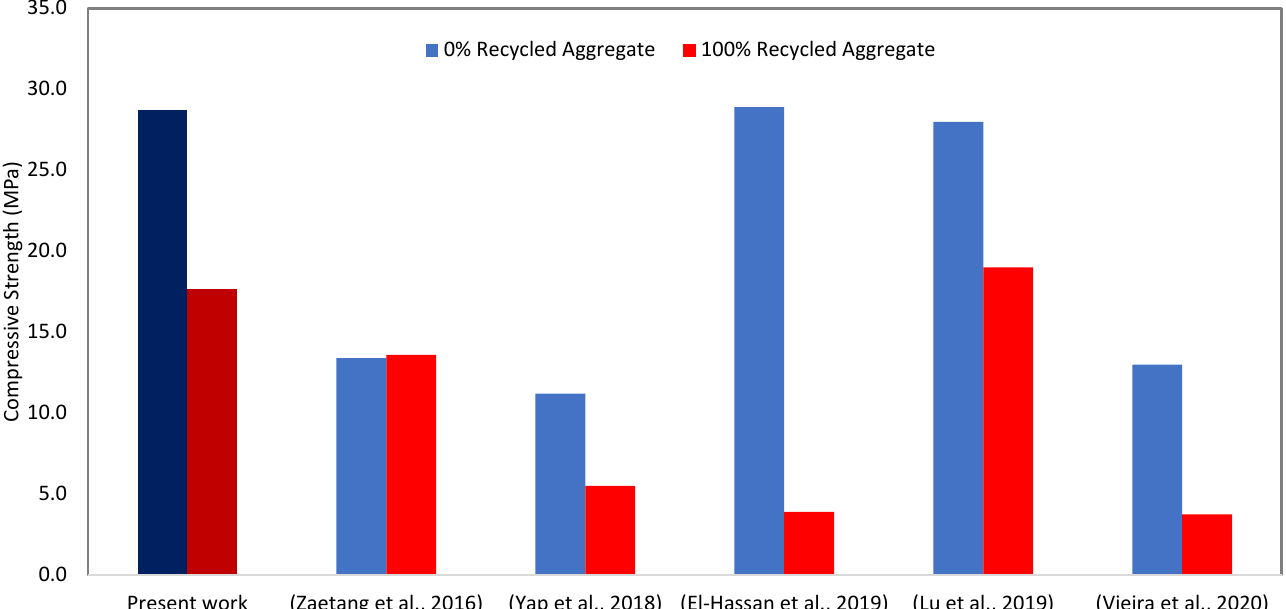
Figure 12. Comparison between the compressive strength values obtained in this study and in other research.